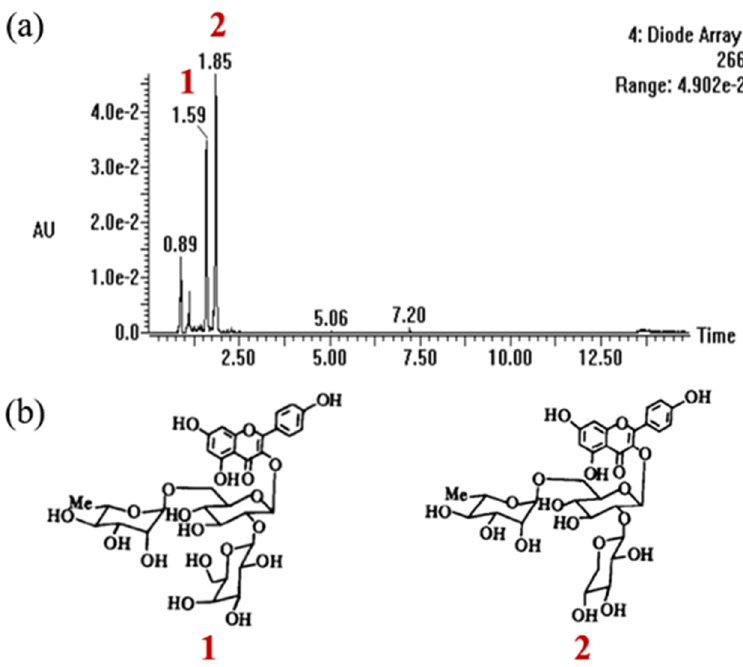
Figure 1. Phytochemical characterization of CSCE ( a ) and chemical structure of components ( b ).